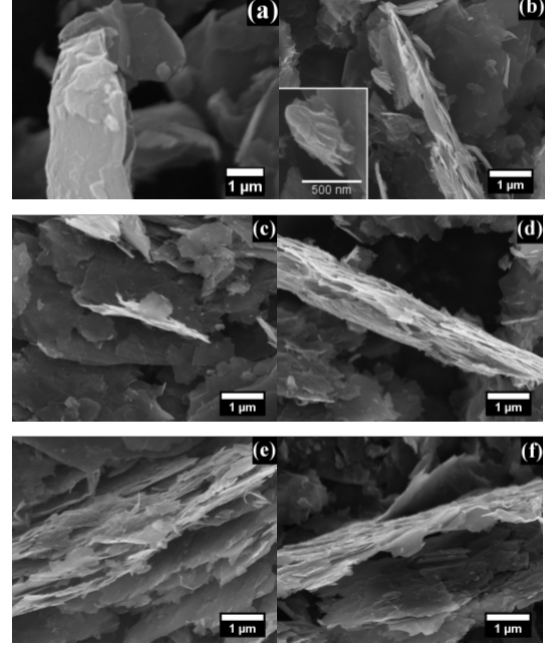
Figure 3. SEM micrographs: (a) starting material (synthetic graphite) and (b) IE2 – milling in ethanol after 2 h, in the inset: morphology of freestanding few-layer graphene (c) IE4 – after 4 h, (d) IE6 – after 6 h, (e) IE8 – after 8 h, (f) IE10 – after 10 h of